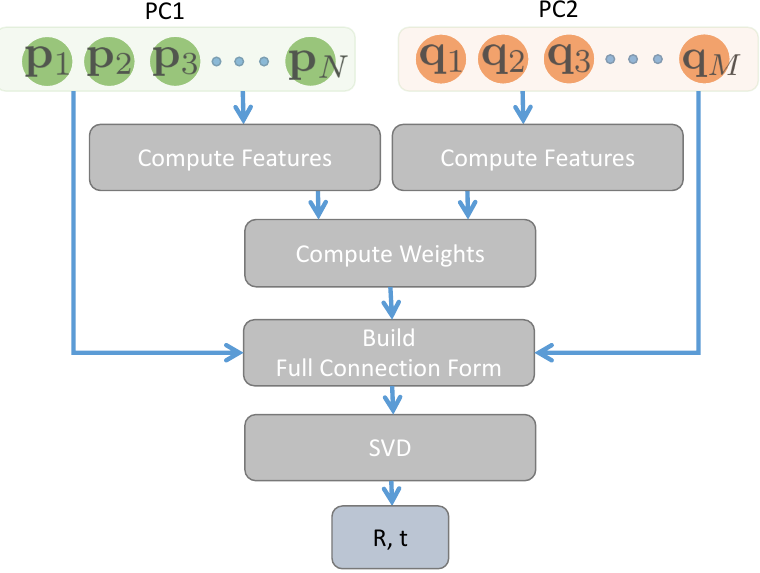
Figure A2. Schematic diagram of the CF registration